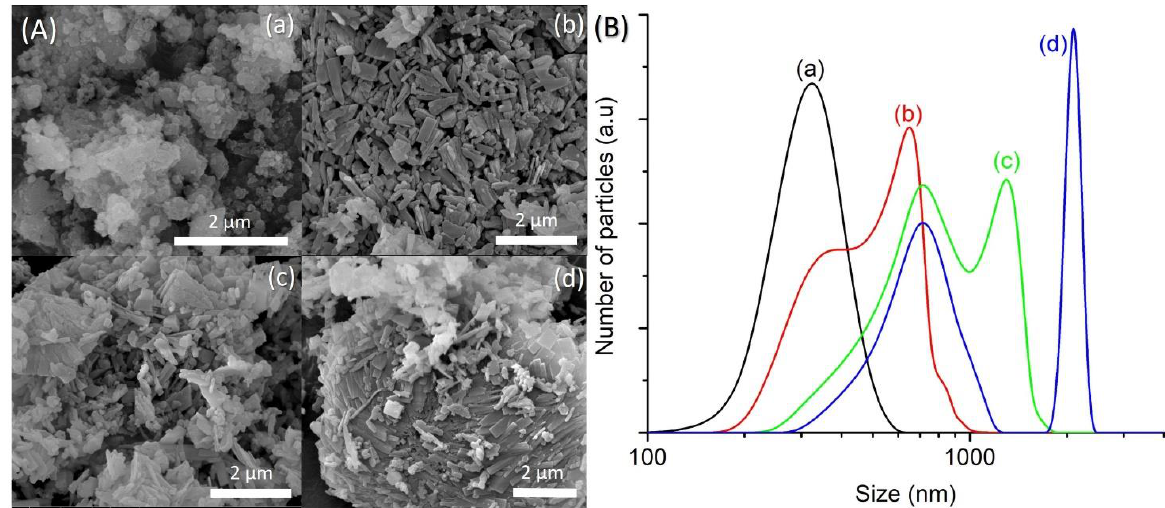
Figure 8. ( A ) FESEM images and ( B ) particle size distributions of ( a ) SH12 ( y = 135), ( b ) SH4 ( y = 180), ( c ) SH13 ( y = 225) and ( d ) SH14 ( y = 270) solid products, which were prepared using precursor hydrogels with a molar composition of 1Al 2 O 3 :2.5P 2 O 5 :2.5[bzmIm] 2 O: y H 2 O: 0.47SiO 2 heated at 150 °C for 10 h.